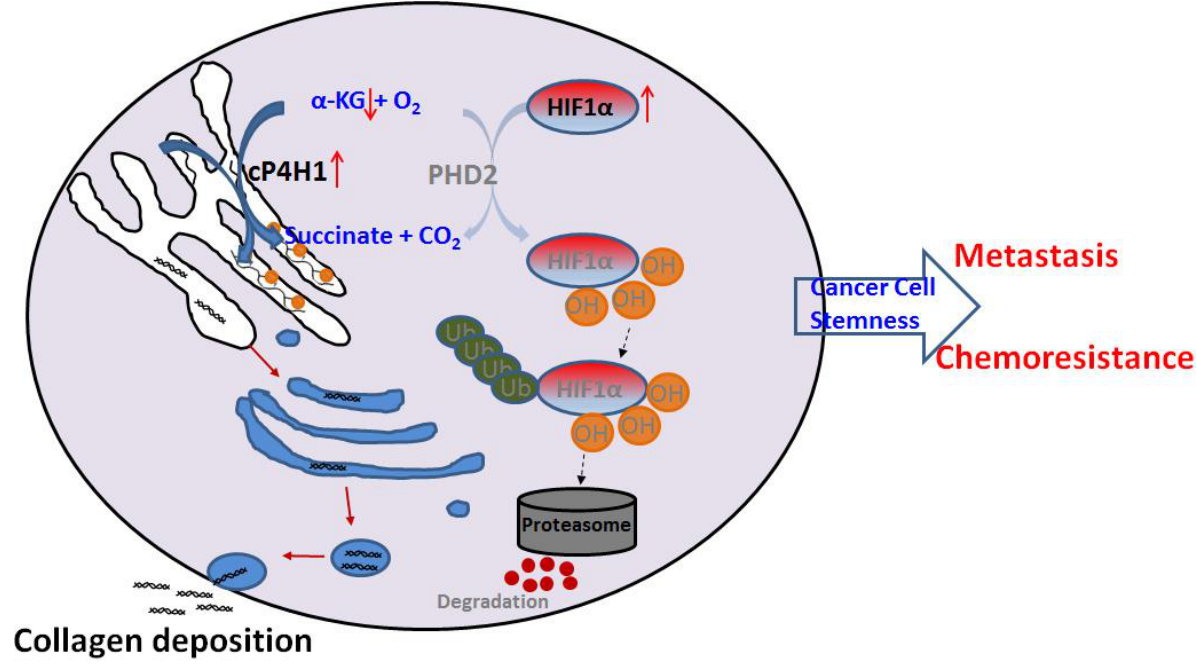
FIGURE 1: A scheme showing the molecular mechanism by which cP4H1 enhances HIF-1stability and cancer cell stemness in